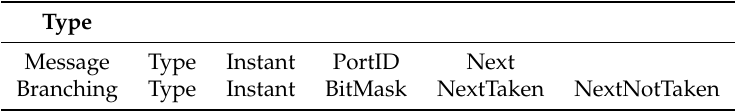
Table 1. Structure of the schedule entries.